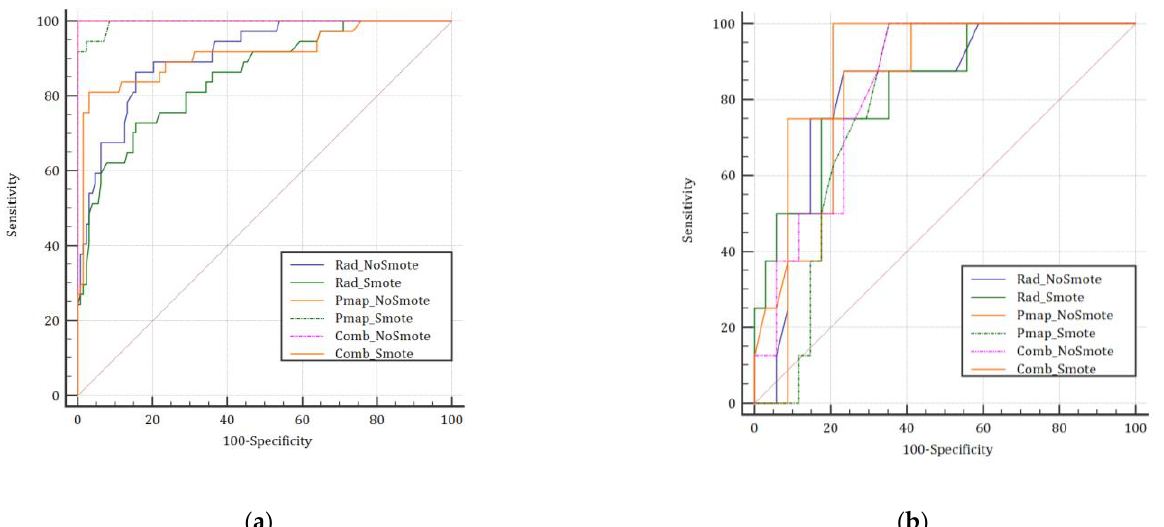
Figure 2. Comparison between each model in the training ( a ) and testing ( b ) sets based on the ROC curve for the prediction of APT ≥ grade 2. Abbreviation: Rad_NoSmote: Radiomics model without Smote, Rad_Smote: Radiomics model with Smote, Pmap_NoSmote: Pmap model without Smote, Pmap_Smote: Pmap model with Smote, Comb_NoSmote: Combined model without Smote, Comb_Smote: Combined model with Smote.